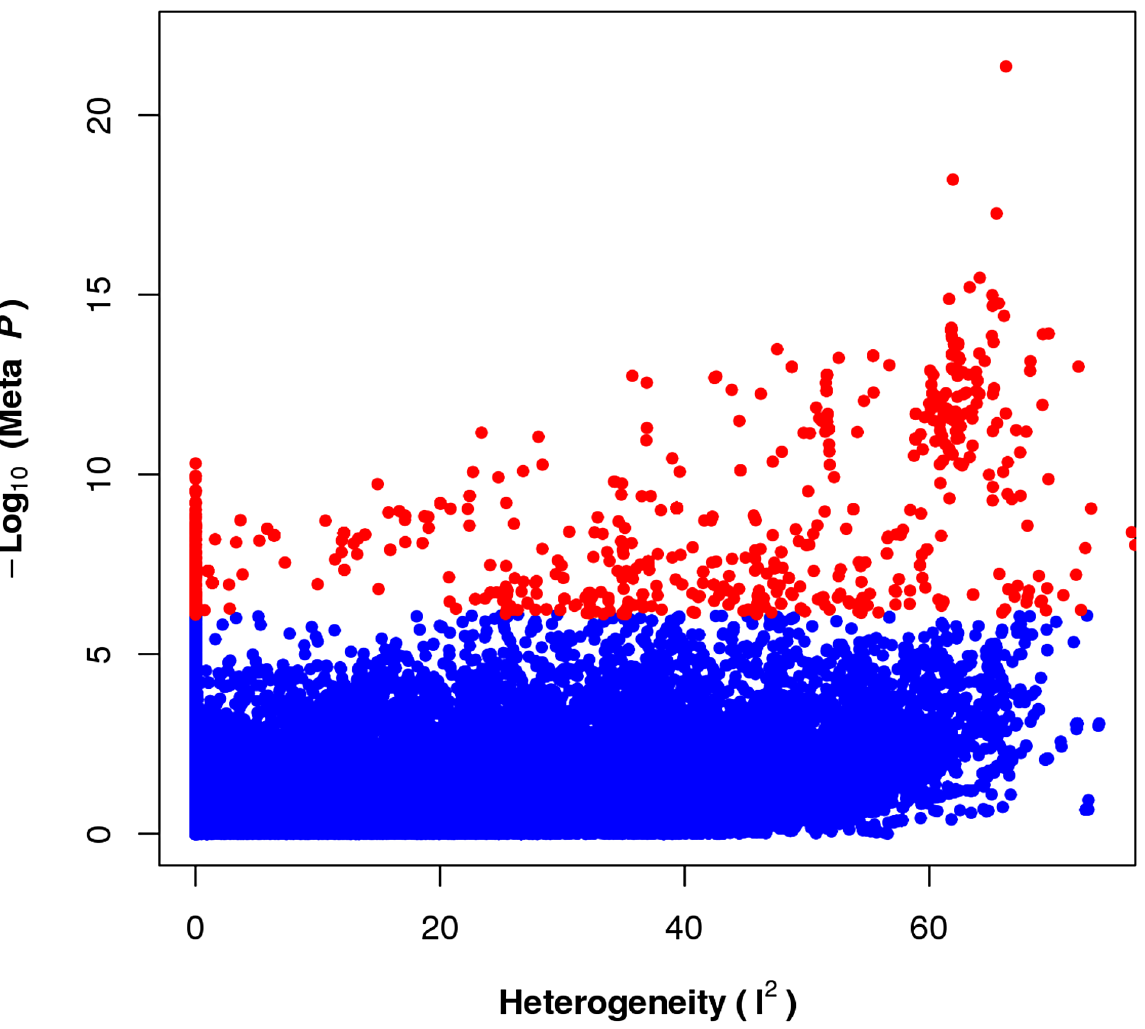
Figure 2. The prevalence of heterogeneity in effect size of significant loci. Each dot represents association between SNPs and HDL phenotype from applying random effects based meta-analysis approach. Dots with larger I 2 value represents the existence of more heterogeneity at the locus between studies. The distribution of the heterogeneity statistic for significant SNPs (red dots) in the meta analysis is skewed toward higher heterogeneity while the non-significant SNPs are much less skewed.